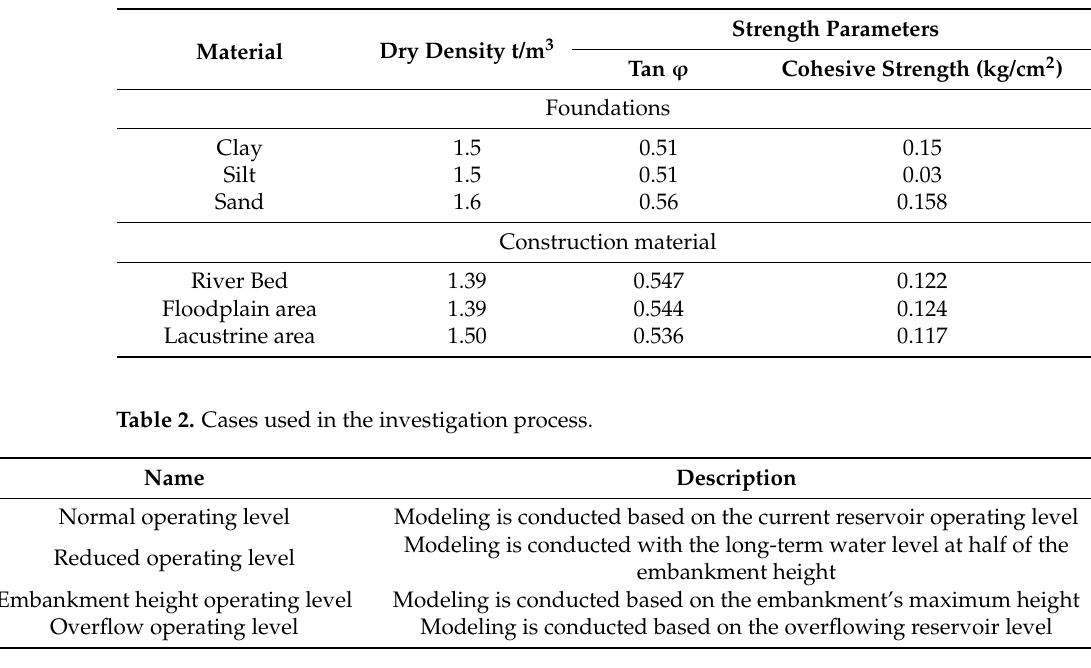
Table 1. General foundation and construction materials properties.